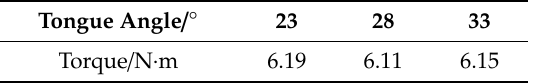
Figure 15. Pressure distribution on volute cross section under design flow rate condition with different volutes. Table 7. Torque of impeller with different volutes.